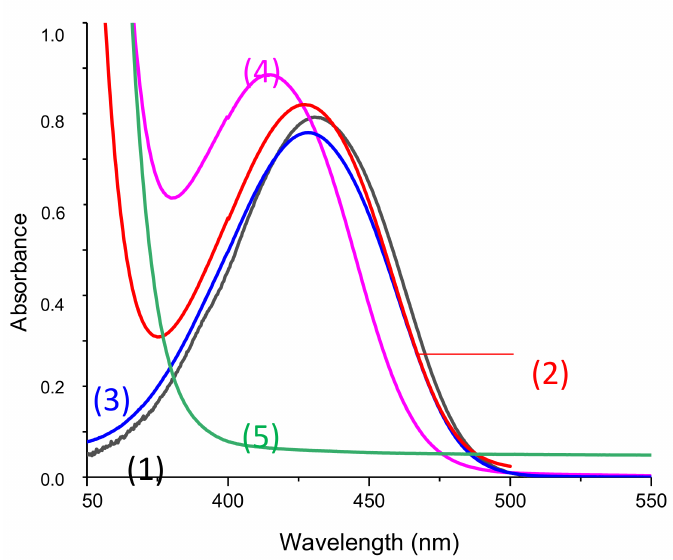
Figure 6. UV-vis spectra of solutions used for photolysis measurement in acetonitrile before any irradiation and in presence of (1)–(4): Napht-B1 (1) alone; (2) with 4-dppba (5.10 − 2 M); (3) with Ar 2 I + / PF 6 − (4.10 − 2 M); (4) with 4-dppba (5.10 − 2 M) and Ar 2 I + / PF 6 − (4.10 − 2 M); and Ar 2 I + / PF 6 − (4.10 − 2 M); and (5) 4-dppba (5.10 − 2 M) and Ar 2 I + / PF 6 − (4.10 − 2 M) in